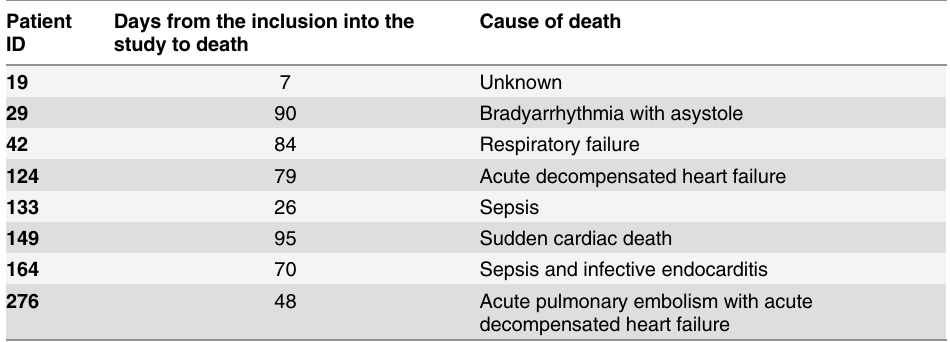
Table 2. Time to death and causes of death during the follow up.